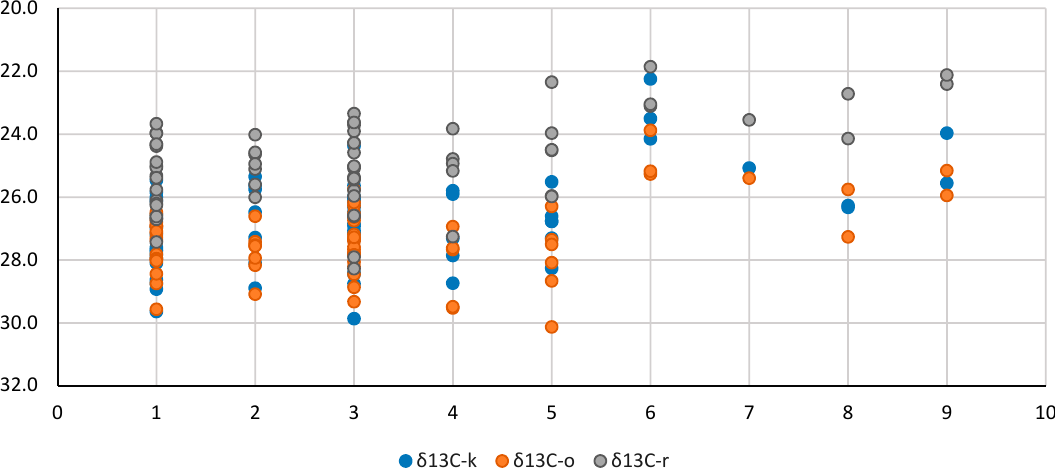
Figure 2. Carbon-13 composition of the kernel, oil and residue taking into account the geographical origin of the cultivars (1 = SCDP-USA cultivars, 2 = SCDP-FR cultivars, 3 = SCDP-RO cultivars, 4 = SCDP-RO selections, 5 = SCDP-RO hybrids, 6 = RO-VL, 7 = RO-DB, 8 = GR, 9 = PRC).